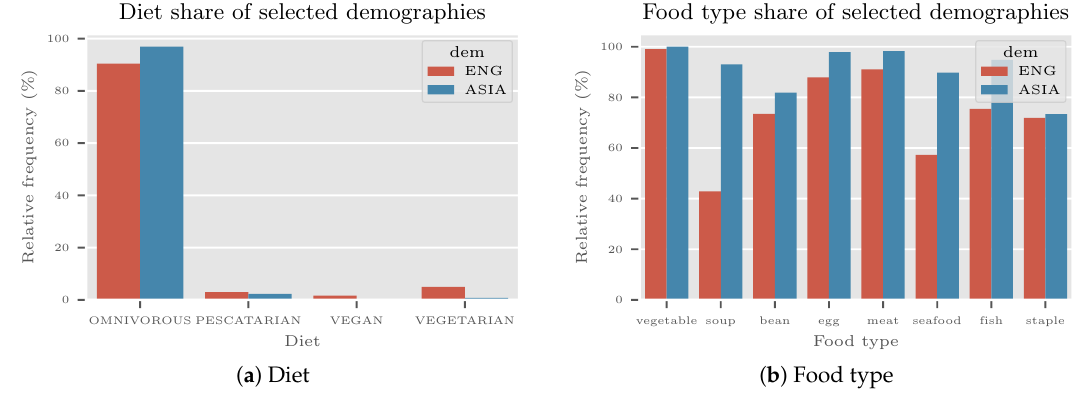
Figure 11. Diet ( a ) and food type ( b ) demographic data of the VireoFood-172 experiment. More than 80% of all subjects were identified as omnivorous and ate meat at least once in the last